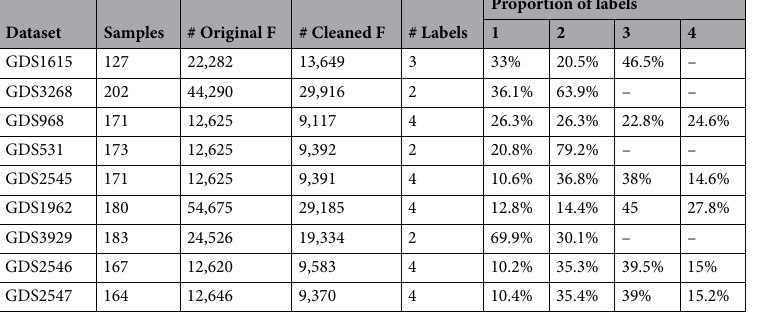
Table 2. Genomic Datasets